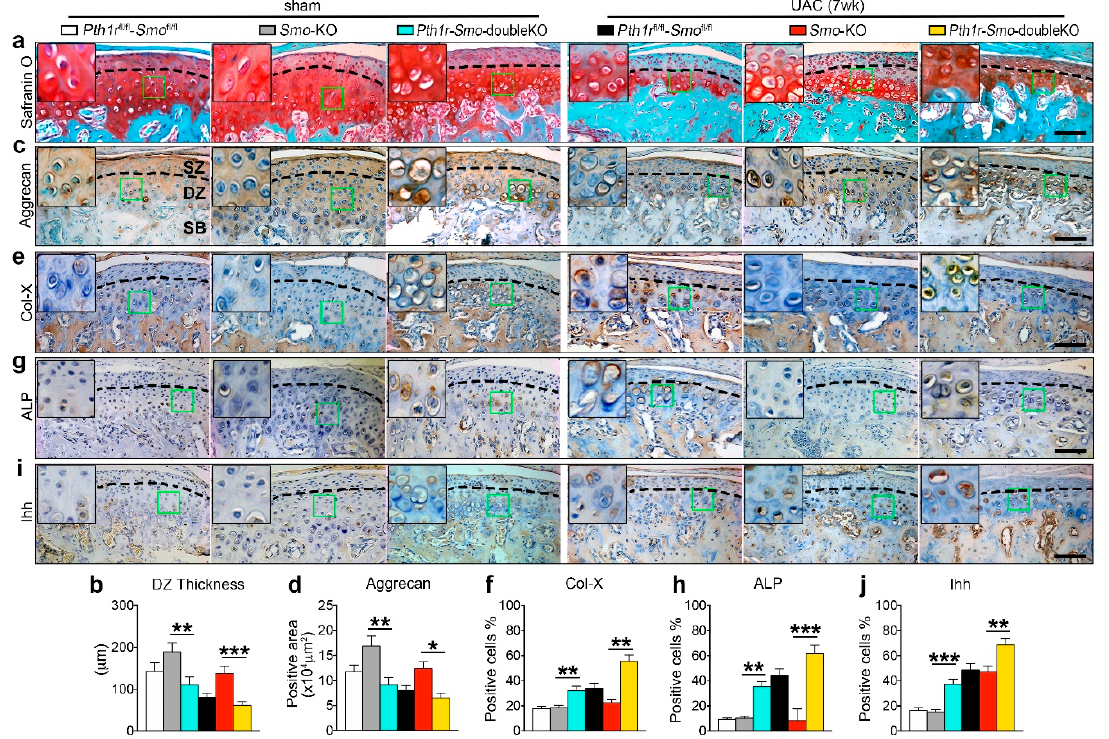
Figure 8. PTH1R dependent effect of Ihh signaling on UAC induced TMJ chondrocytes terminal differentiation. Cartilage-specific and tamoxifen-inducible Pth1r and Smo gene double knockout mice ( Pth1r-Smo -double KO) were treated with UAC for 7 weeks. The Smo fl/fl - Pth1r fl/fl mice were used as a blank control and Smo knockout as a positive control. ( a , b ) Safranin O staining and its quantification. ( c – j ) Immunohistochemical staining and the quantification of aggrecan ( c , d ), Col-X ( e , f ), ALP ( g , h ), and Ihh ( i , j ). The green box regions in the images were magnified at the top left corner. Black dotted lines distinguish the superficial and deep zone chondrocyte. SZ , superficial zone. DZ , deep zone. SB , subchondral bone. Magnification, 200×. Scale bar, 100 μ m. n = 6. Results are represented as the mean ± SD. * p < 0.05, ** p < 0.01, *** p < 0.001.